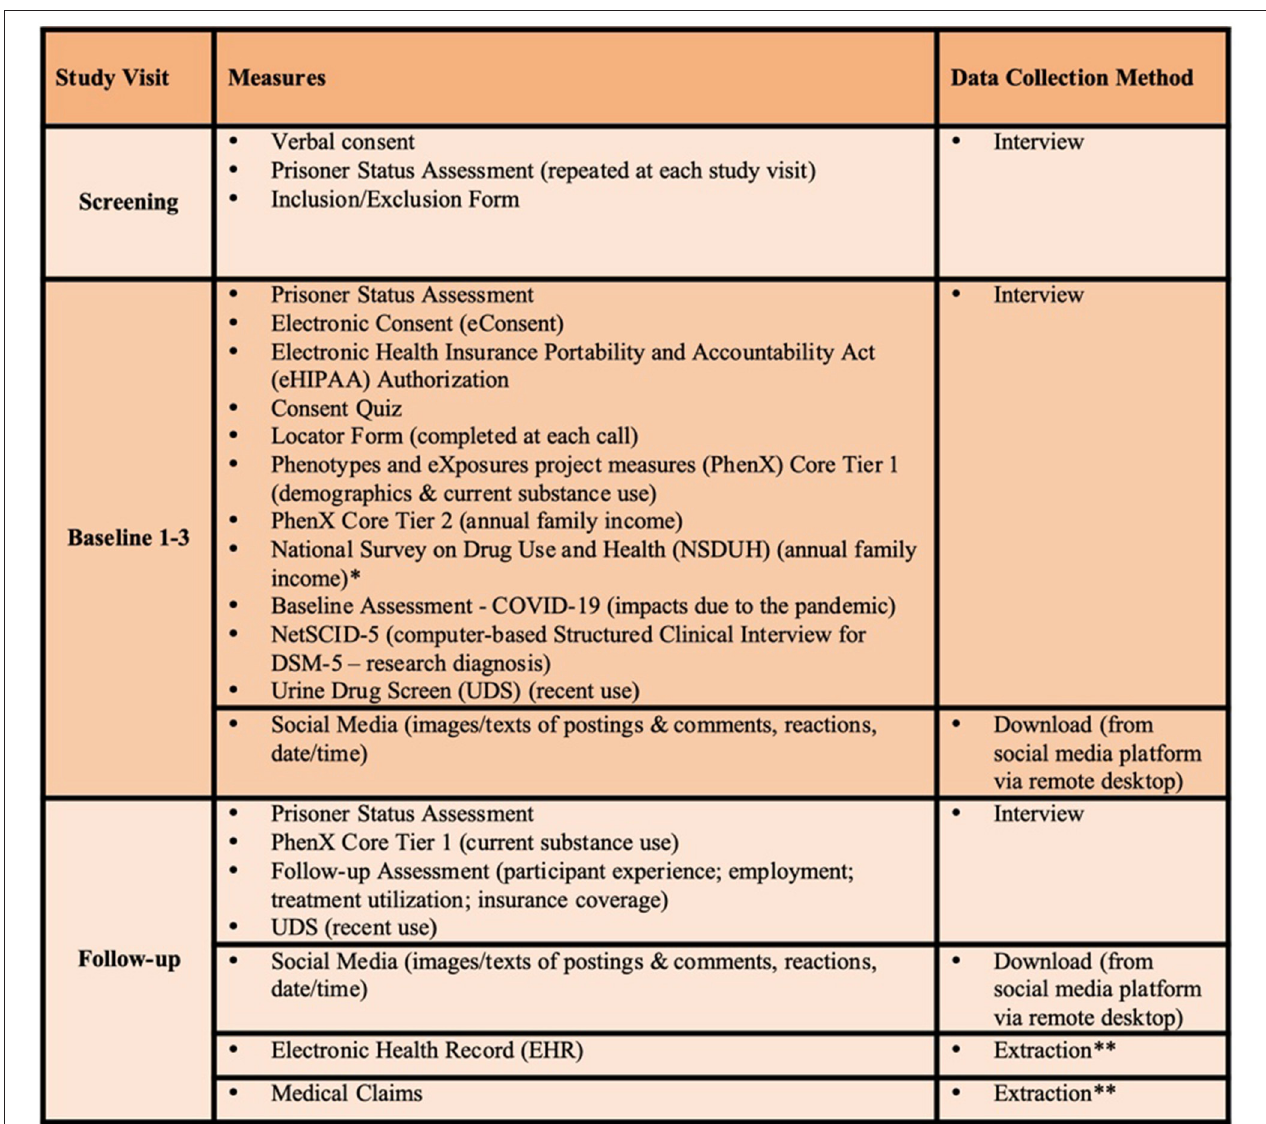
FIGURE 2 | Table of study assessments. *NSDUH is only collected for participants who are unsure of the total family income. We will use as subset of questions to determine which income category best characterizes total combined family income. **EHR/Medical Claims data will be extracted by the data analyst ∼ 16 weeks after completion of study and includes data 12 months prior to EMA start through 12 weeks post-EMA